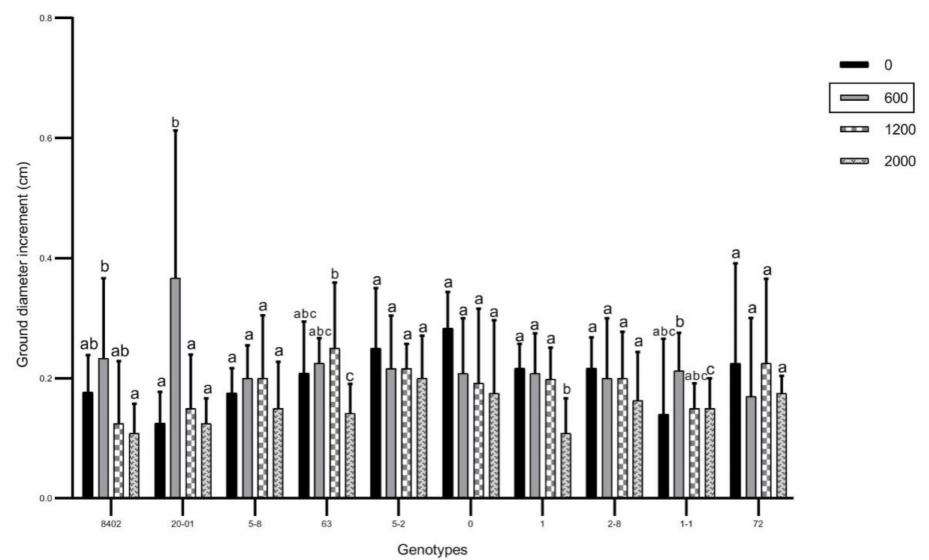
Figure 2. Effects of Sb concentration on ground diameter increment of Catalpa bungei .